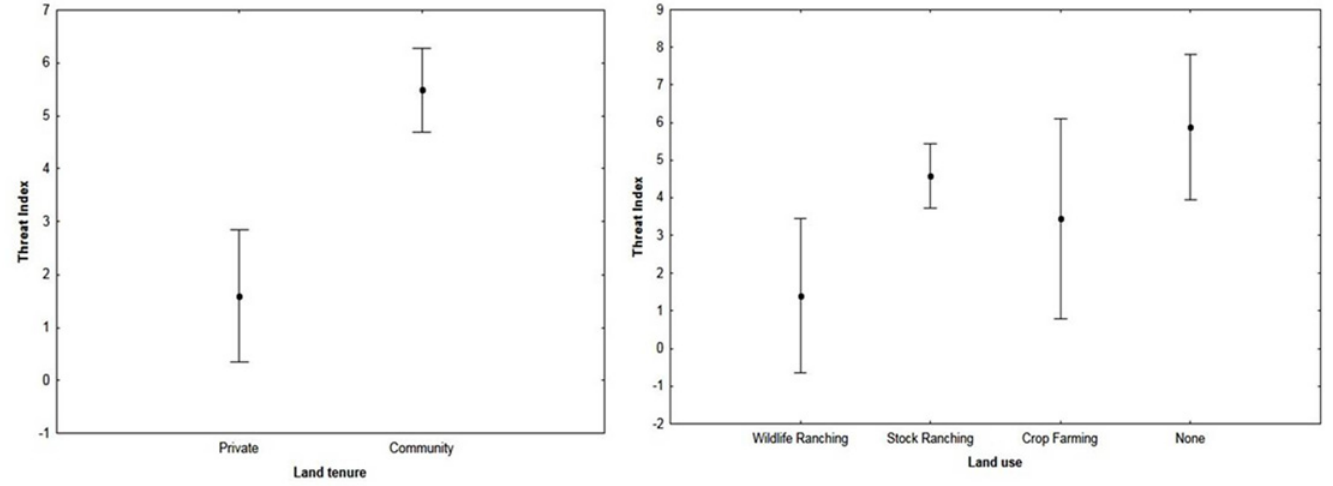
Fig 5. The relationships between the threat index of a respondent and their properties land use (F (3; 123) = 3.75; p < 0.05) and land tenure (F (1;116) = 16.44; p < 0.05) was found to be